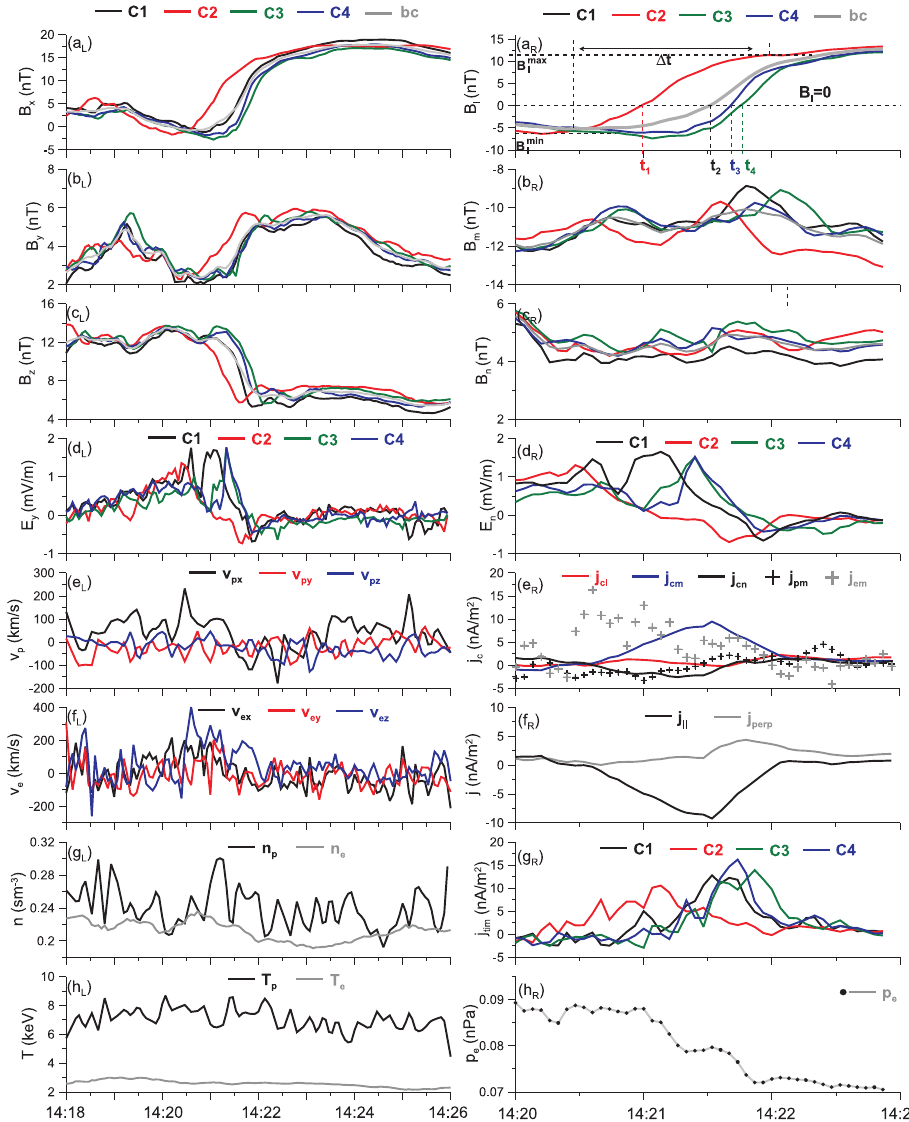
Fig. 2. Right and left panels present parameters of CS 29 in GSM and local coordinate systems, respectively. ( a L , R – c L , R ) X,Y,Z and l , m , n components of the magnetic field B (α) measured at spacecraft Cα ( α = 1 − 4) and the same components of the magnetic field B c in the barycenter (bc); ( d L , R ) y and n components of electric fields E (α) (measured at Cα ); ( e L , f L ) components of proton and electron bulk velocities v p and v e ; ( g L , h L ) proton and electron densities ( n p , e ) and temperatures ( T p , e ); ( e R ) l , m , n components of the curlometer current density j c ; proton j pm and electron j em current densities along vector m ; ( f R ) field-aligned j k and perpendicular j ⊥ components of the curlometer current j c ; ( g R ) current densities j (α) determined by the timing method; ( h R ) electron pressure p e = n e T e . We use the proton tim moments provided by C1 and electron moments provided by